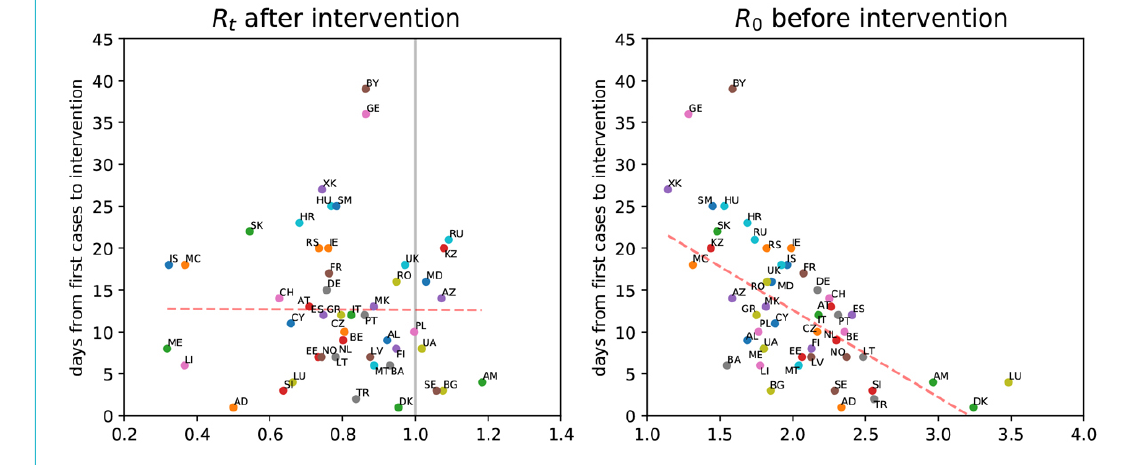
Figure 6: Inferred mean reproduction number before ( R 0 , right) and after intervention ( R t , left) vs the time of the start of interventions t int − ½ δ int measured from the beginning of the epidemic in each country. The dots have the same colours as in figure 5 and the country codes are listed in table 2. The red dashed line shows the linear regression of the intervention time with respect to R 0 and R t